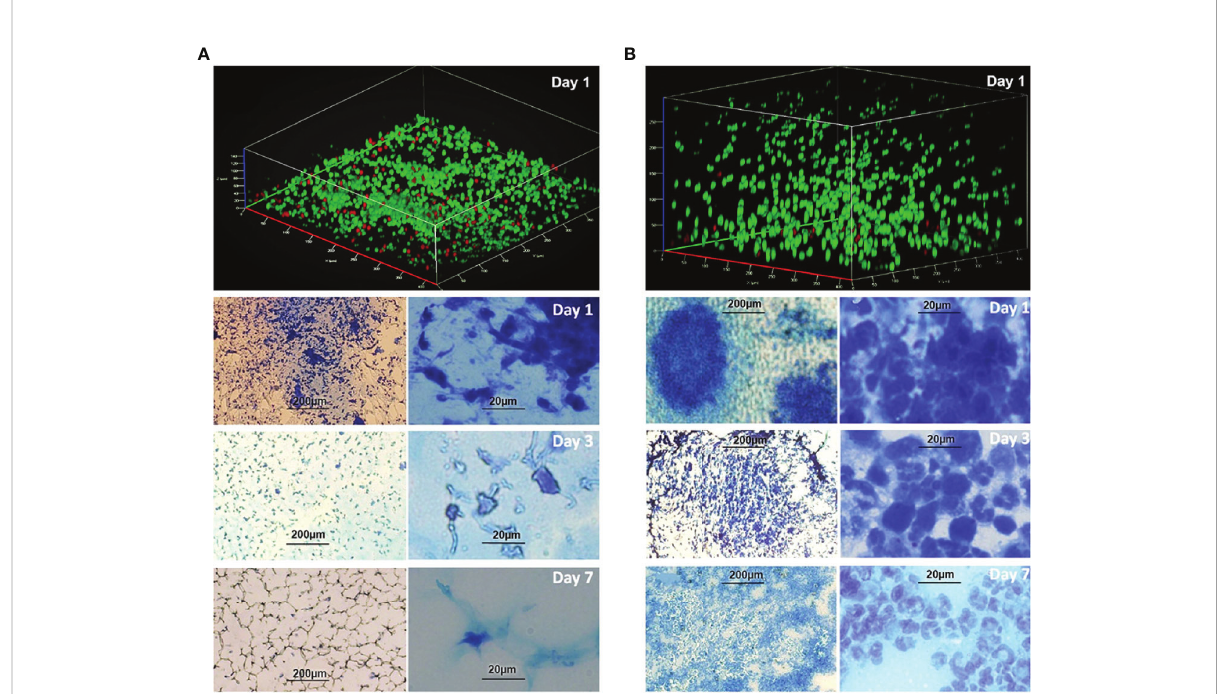
FIGURE 3 In fi ltration of phagocytes in the PF hydrogels without (A) and with (B) P. aeruginosa PAO1 in vivo. Images were acquired in PF hydrogels harvested from mouse peritoneal cavities at days 1, 3, and 7 after implantation and were stained with live/dead stain or methylene blue. (A) Upper image: CLSM micrograph of live/dead stained sterile PF hydrogel indicates that it was penetrated by a thin layer (ca. 40 µm) of phagocytes. Lower images: In fi ltration of phagocytes in the sterile PF hydrogels visualized by light microscopy at different magni fi cations (bar sizes: left, 200 µm; right, 20 µm). The phagocytes in the PF hydrogels were mostly peritoneal macrophages, and the in fi ltrations were remarkable only at day 1, reduced signi fi cantly at day 3, and disappeared completely at day 7. (B) Upper image: CLSM micrograph of live/dead stained bacteria-containing PF hydrogel indicates that it is penetrated by a thick layer (> 250 µm) of phagocytes. Lower images: In fi ltration of phagocytes in the PF hydrogels visualized by light microscopy at different magni fi cations (bar sizes: left, 200 µm; right, 20 µm). The images show a high density of host immune cells in the PF hydrogels predominated by PMNs, and the in fi ltration of PMNs was continuously observed in the whole study period. PMNs migrated toward and stayed close to the bacterial bio fi lms. The PMNs dispersed widely following the development of bio fi lm at days 3 and